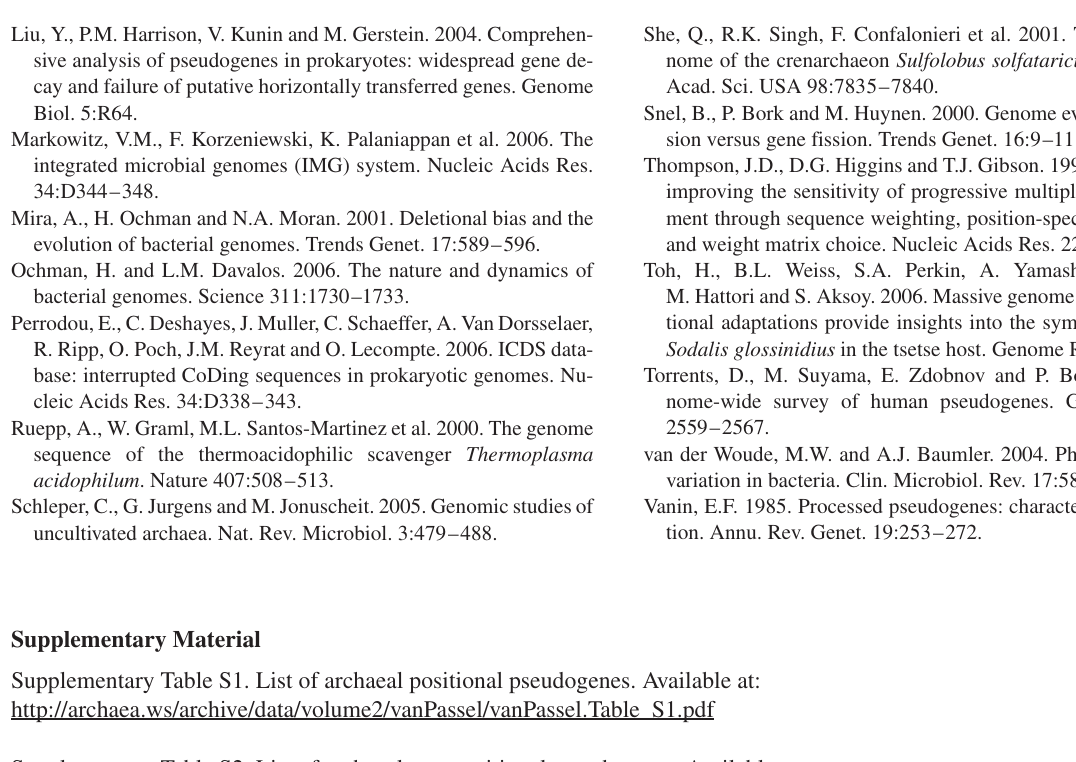
Supplementary Figure S1. Numbers of pseudogenes and their mechanisms of inactivation in each of the archaeal genomes consid- ered. Available at: